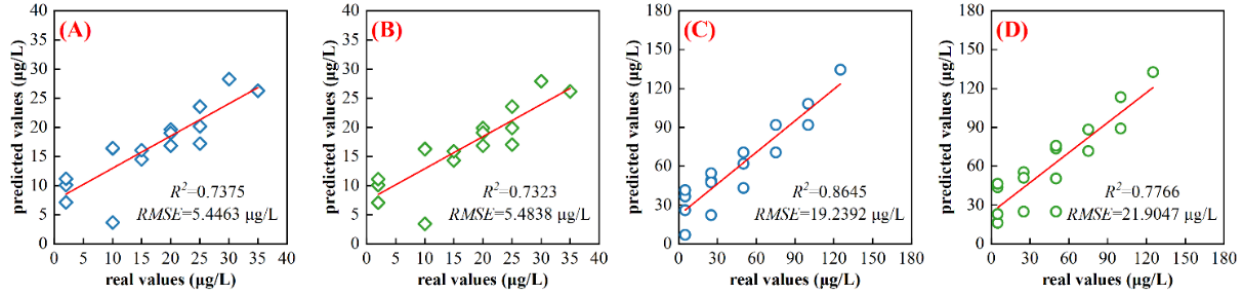
Figure 6. PLSR model results for Cd 2+ ( A , B ) and Pb 2+ ( C , D ) concentration detection in the validation dataset. (Diamond scatters represent Cd 2+ concentrations, circular scatters represent Pb 2+ concentrations, blue scatters represent the model input as I manu , green scatters represent the model input as I algo ).